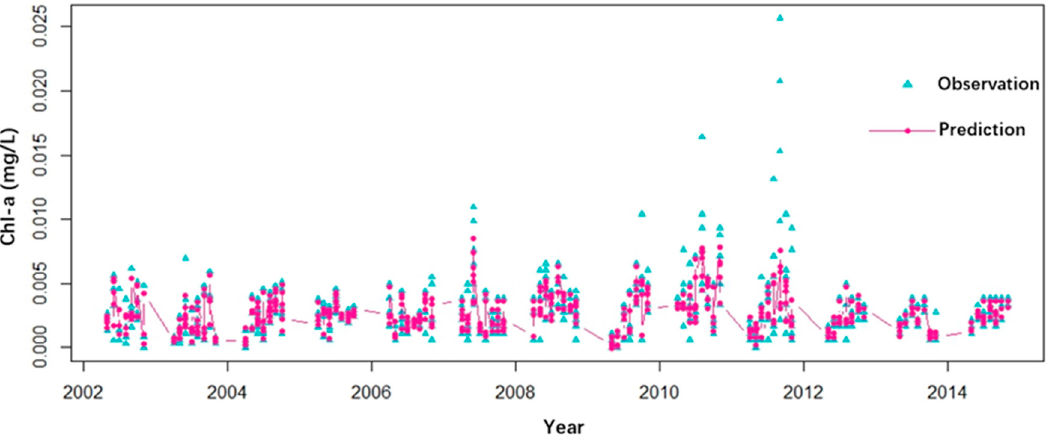
Figure 6. Prediction results of SVM model in train stage.